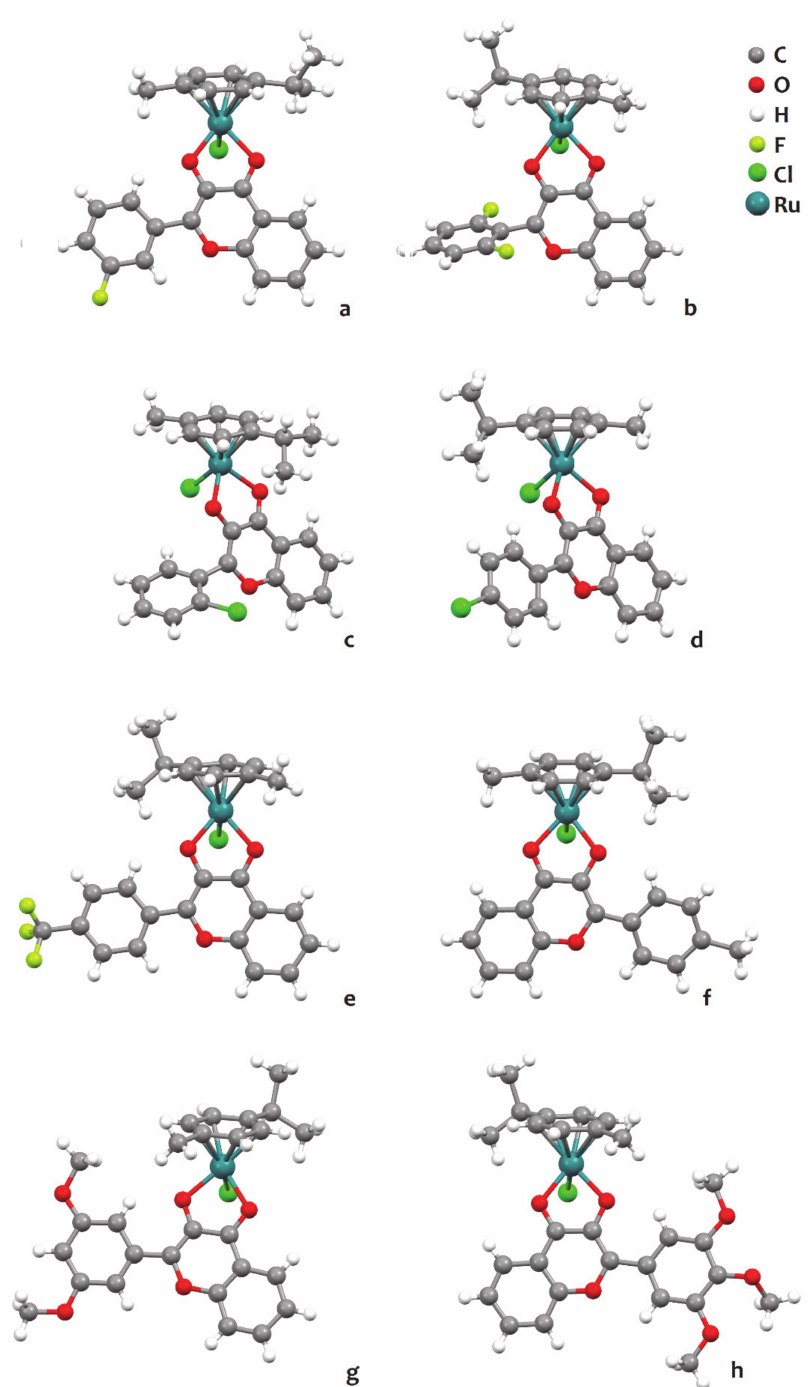
Figure 8. Structures of ruthenium p -cymene ( p -cym) complexes with flavonol (3-hydroxyflavone) derivatives: ( a ) [Ru( p -cym)(3 (cid:48) -fluoroflavonol)Cl] (CCDC refcode VEMVAM); ( b ) [Ru( p -cym)(2 (cid:48) ,5 (cid:48) - difluoroflavonol)Cl] (ODELER); ( c ) [Ru( p -cym)(2 (cid:48) -chloroflavonol)Cl] (VEMTOY); ( d ) [Ru( p -cym)(4 (cid:48) - chloroflavonol)Cl] (VEMTUE); ( e ) [Ru( p -cym)(4 (cid:48) -trifluoromethylflavonol)Cl] (ODELIV); ( f ) [Ru( p - cym)(4 (cid:48) -methylflavonol)Cl] (SARBIY); ( g ) [Ru( p -cym)(3 (cid:48) ,5 (cid:48) -dimethoxyflavonol)Cl] (ODEKUG), and ( h ) [Ru( p -cym)(3 (cid:48) ,4 (cid:48) ,5 (cid:48) -trimethoxyflavonol)Cl] (ODELAN), all represented using the ball-and-stick style. Redrawn from the atomic coordinates available at the CCDC using the software Mercury 3.7, omitting co-crystalisation solvent molecules for